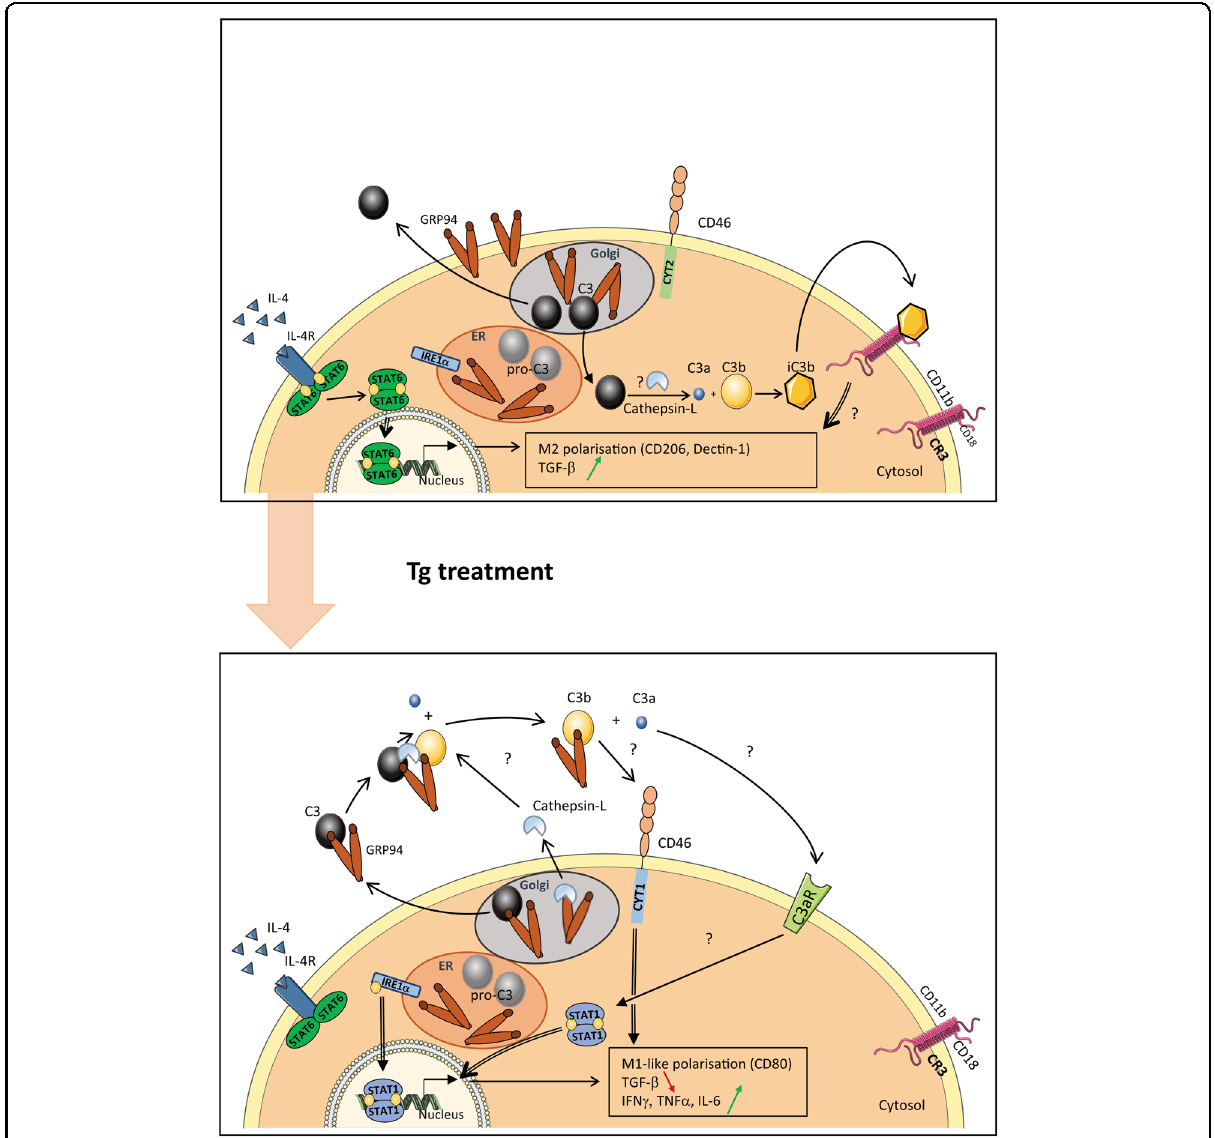
Fig. 8 Hypothetic scheme integrating GRP94 and C3 in basal and Tg treated M2 macrophages. Upper panel: M2 macrophages are activated by IL-4/STAT6 signalization and express membrane GRP94 as well as high levels of CD11b/CD18 complement receptor CR3 and mainly CYT2 CD46 isoforms. C3, although found in the extracellular medium, is not cleaved because of the absence of extracellular cathepsin L. Within the cell, cathepsin L may cleave C3, thus generating C3b that is then inactivated in its iC3b fragment. Binding of iC3b on its receptor CR3 may contribute to the M2 phenotype. Lower panel: Under Tg-induced ER stress, the IL-4/STAT6 signalization is inhibited. GRP94 cell surface expression is highly decreased as well as CD11b and membrane-bound iC3b. Intracellular GRP94 interacts extensively with C3 and they are both secreted. Cathepsin-L is also secreted and can cleave C3 extracellularly into C3b and C3a. Both fragments may induce the pro-in fl ammatory pro fi le pSTAT1 + , C3b being no more inactivated and interacting with CD46 CYT1 isoform which is increased, while C3a can interact with its receptor